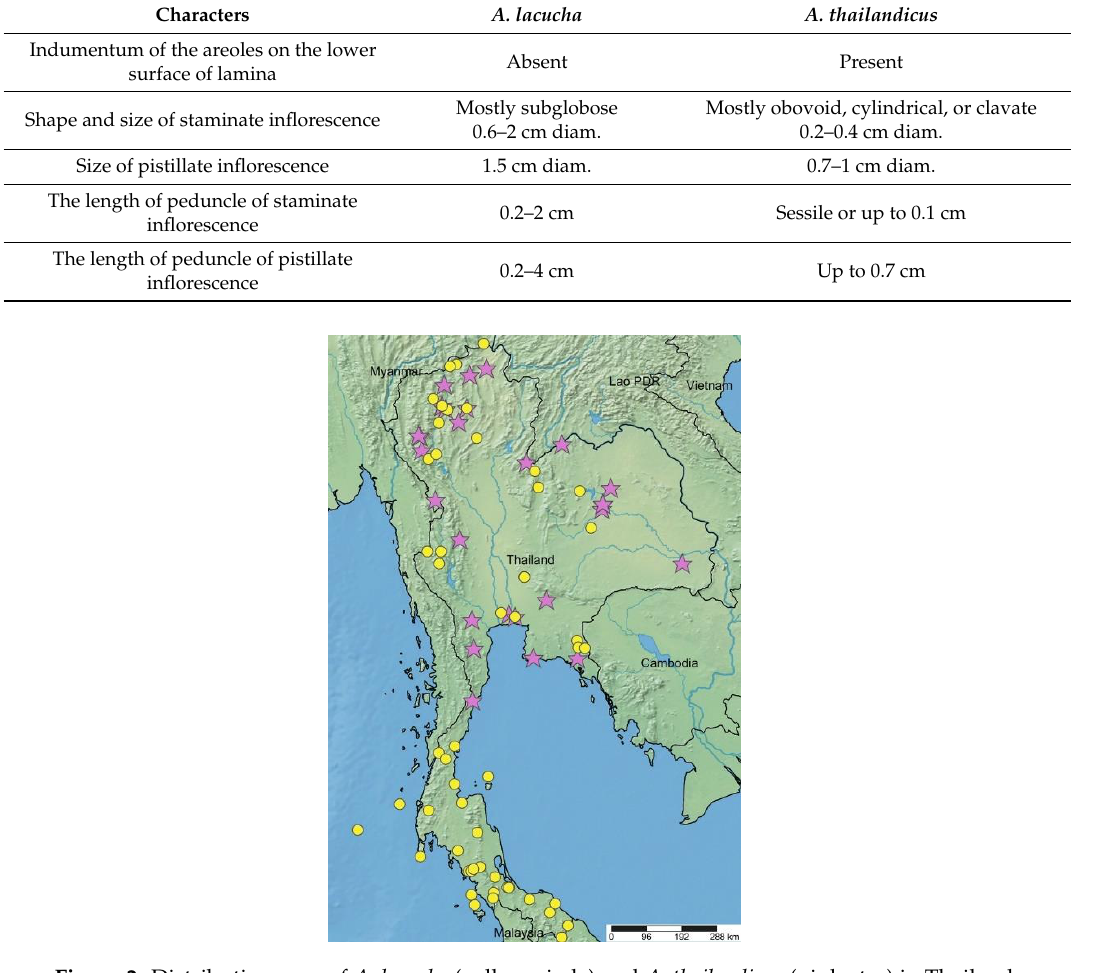
Figure 2 . Distribution map of A. lacucha (yellow-circle) and A. thailandicus (pink-star) in Thailand.